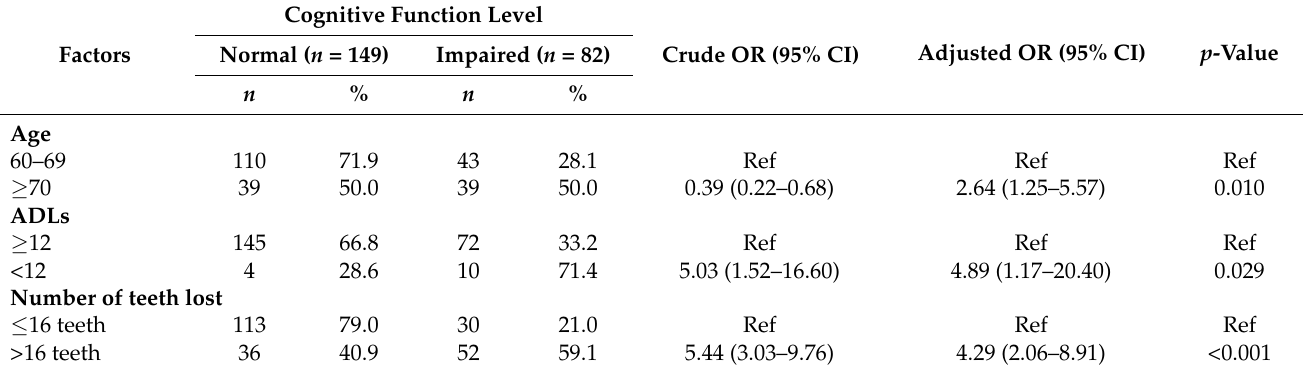
Table 2. Factors associated with level of cognitive functioning among